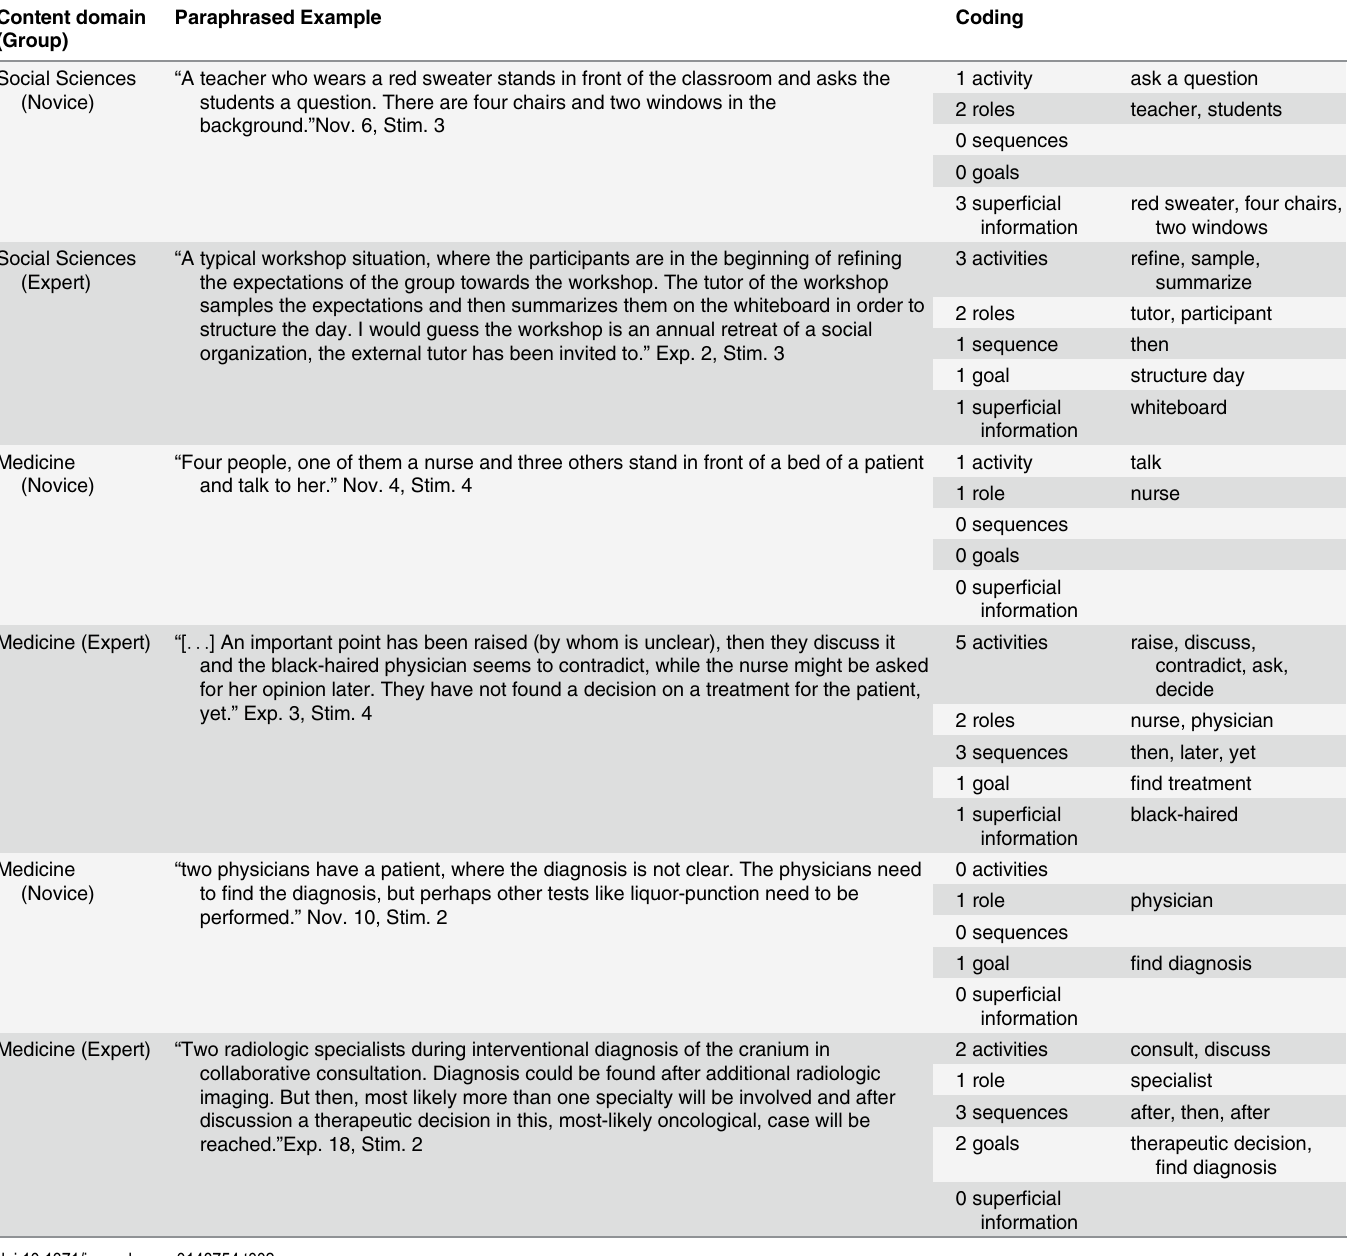
Table 2. Paraphrased Examples of Experts and Novices from Social Sciences and Medicine Content domain